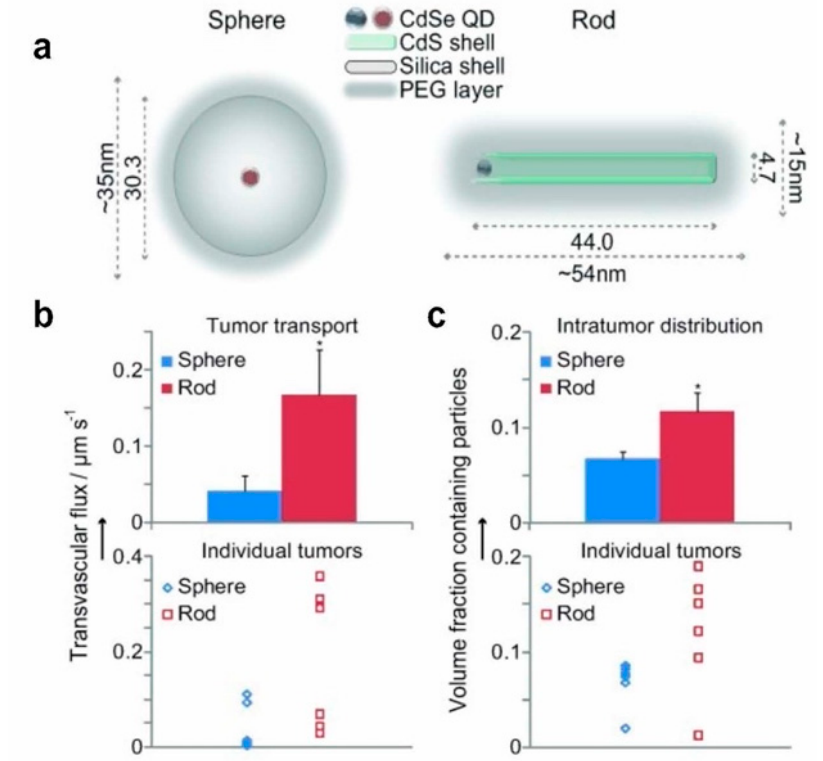
Figure 6. The effect of nanoparticle shape on tumor targeting. ( a ) Schematic diagram of nanospheres and nanorods. ( b ) Transvascular transport rates of orthotopic E0771 mammary tumors in mice. Nanorods were transported 4.1 times faster on container walls than nanospheres. ( c ) Nanoparticle distribution in mouse orthotopic E0771 mammary tumors. Nanorods penetrated 1.7 times the volume of distribution of nanospheres. Reprinted with permission from Ref. [158]. Copyright 2011, Wiley − VCH.